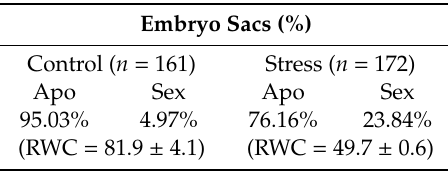
Table 1. Percentage of sexual and apomictic embryo sacs in the control and water-stressed E. curvula plants (Don Walter cultivar) and the relative water content (RWC) for each